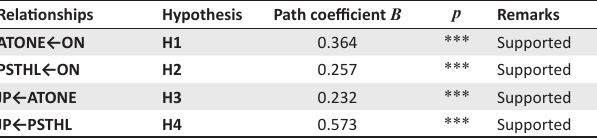
TABLE 6: Summary of hypotheses testing.